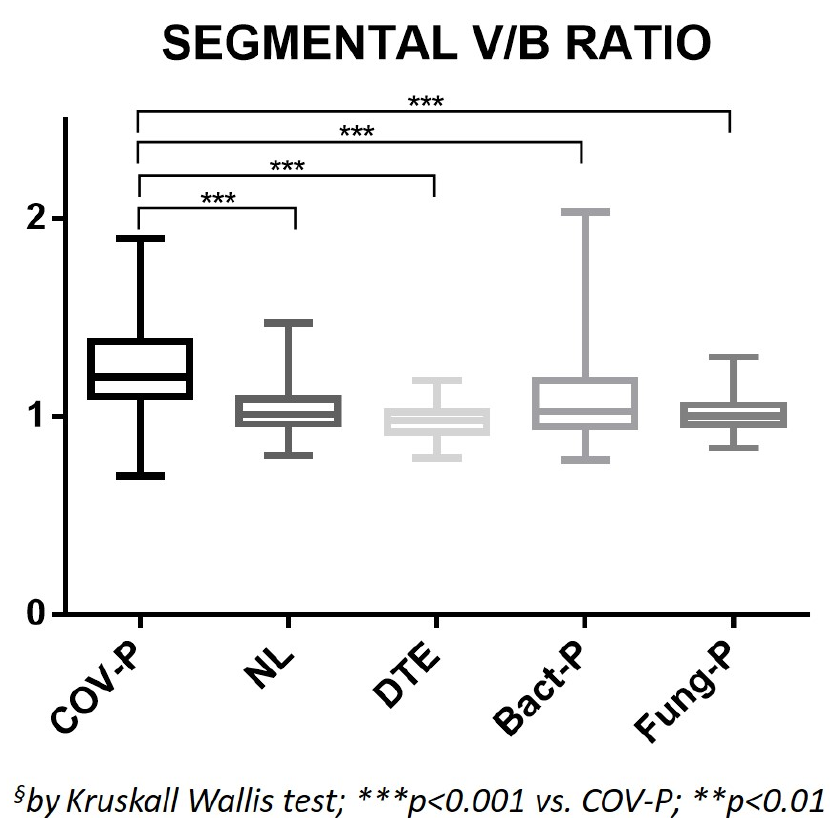
Table 1. Ratio between the caliber of the segmental and subsegmental branches of the pulmonary arteries and their corresponding bronchial branches, measured on healthy lung parenchyma.